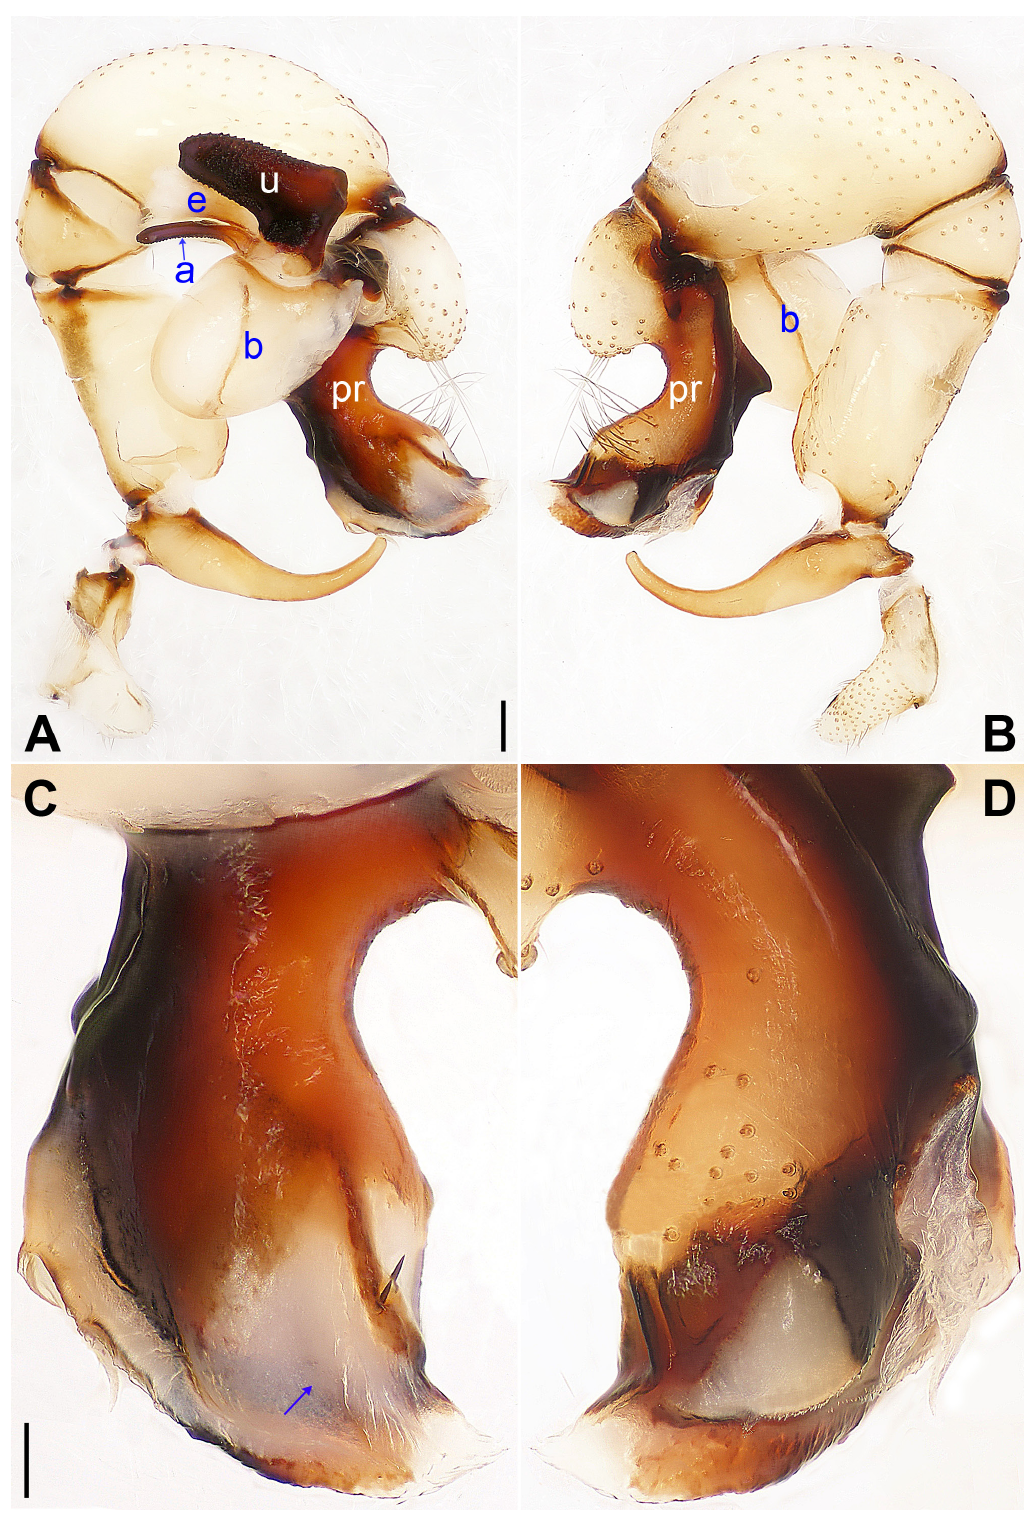
Fig. 3. Pholcus shuguanensis Yao & Li sp. nov., holotype, ♂. A–B . Pedipalp (A. Prolateral view. B. Retrolateral view). C–D . Distal part of procursus (C. Prolateral view, arrow points at large, prolateral membranous area distally. D. Retrolateral view). Abbreviations: a = appendix; b = bulb; e = embolus; pr = procursus; u = uncus. Scale bars: A–B = 0.20 mm; C–D = 0.10